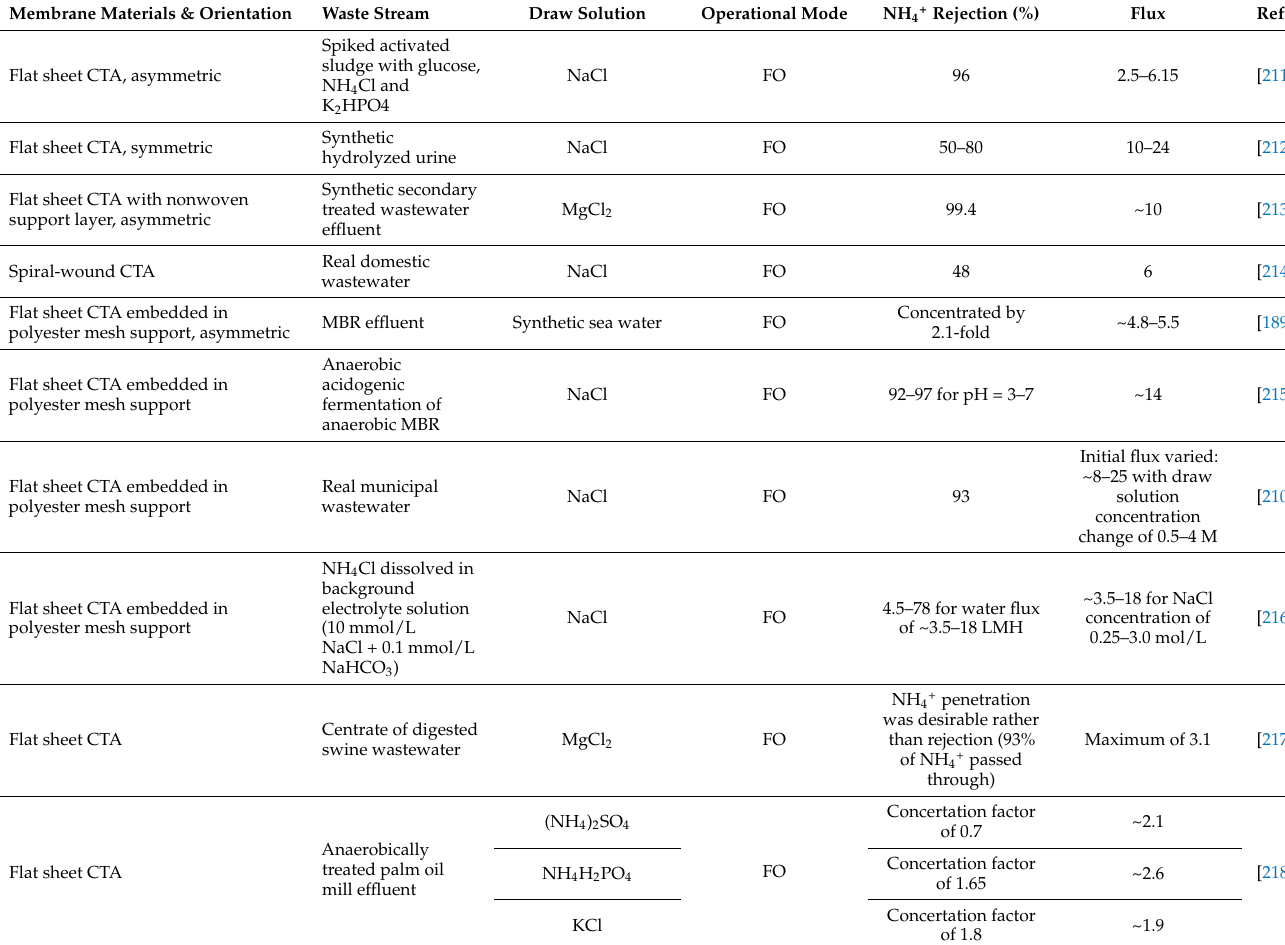
Table 5. Literature summary for nitrogen recovery with FO